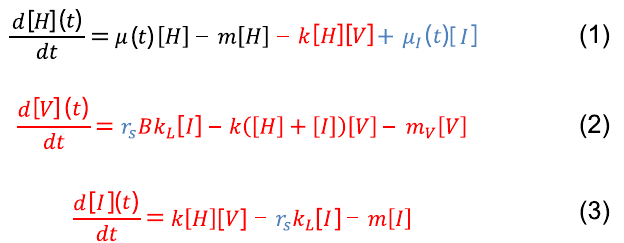
Fig. 6 Dynamic equations describing all versions of our models. [H], [V], and [I] represent densities of uninfected hosts, viruses, and infected hosts, respectively. The growth of a host population in the absence of viruses is presented in black; the additions for the classic virulent model in red; and the additions to represent temperate dynamics are presented in blue. See text for further description of terms and